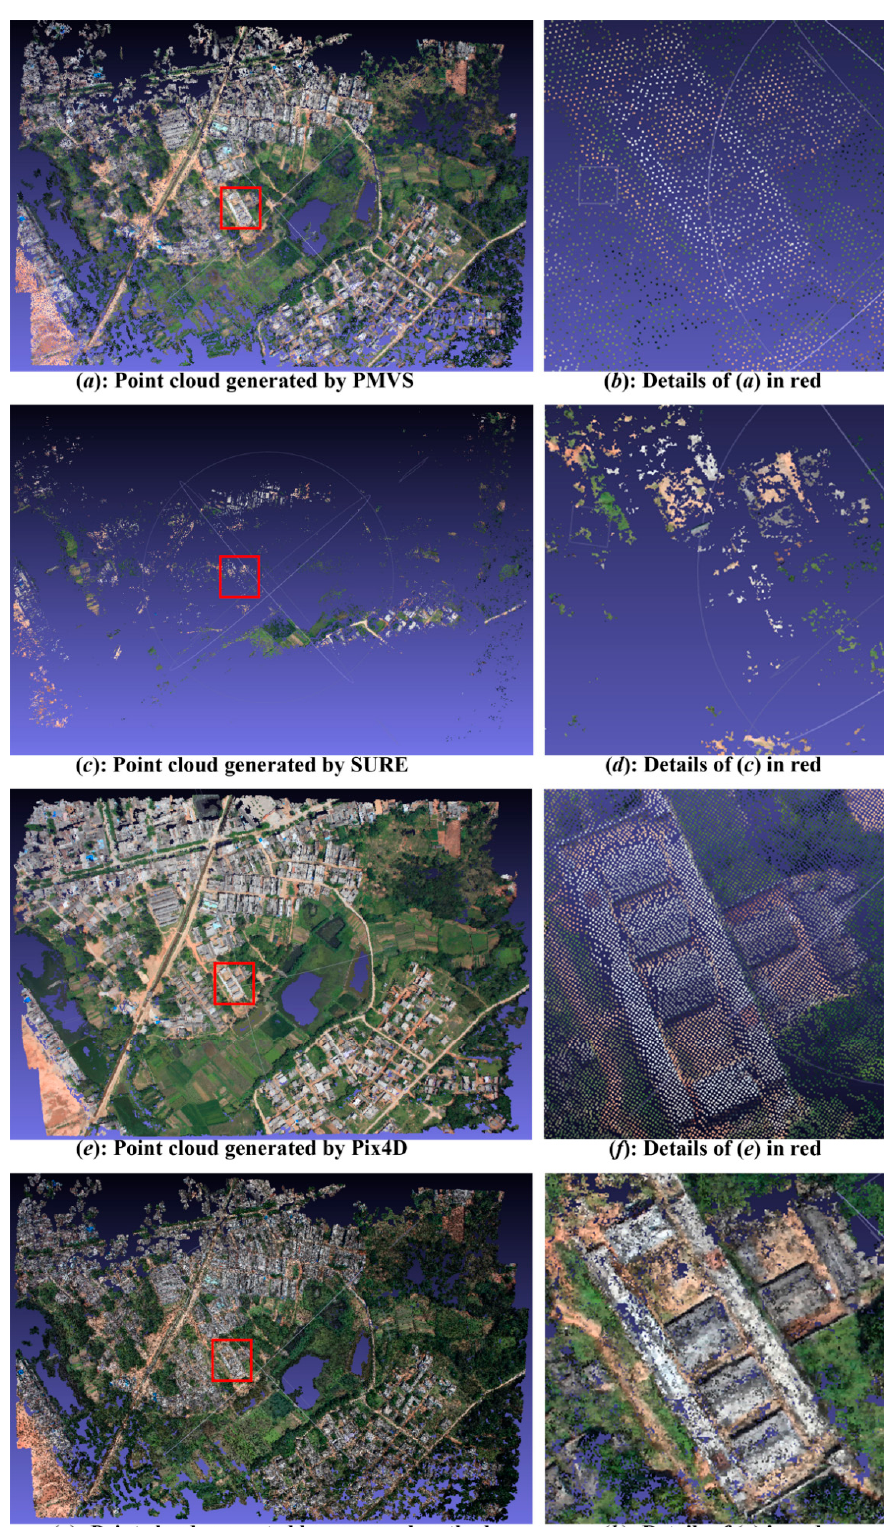
Figure 7. Examples of reconstructed point cloud with Hainan images illustrated by software MeshLab. ( a ) Point cloud generated by PMVS; ( b ) Details of ( a ) in red; ( c ) Point cloud generated by SURE; ( d ) Details of ( c ) in red; ( e ) Point cloud generated by Pix4D; ( f ) Details of ( e ) in red; ( g ) Point cloud generated by proposed method; ( h ) Details of ( g ) in red.